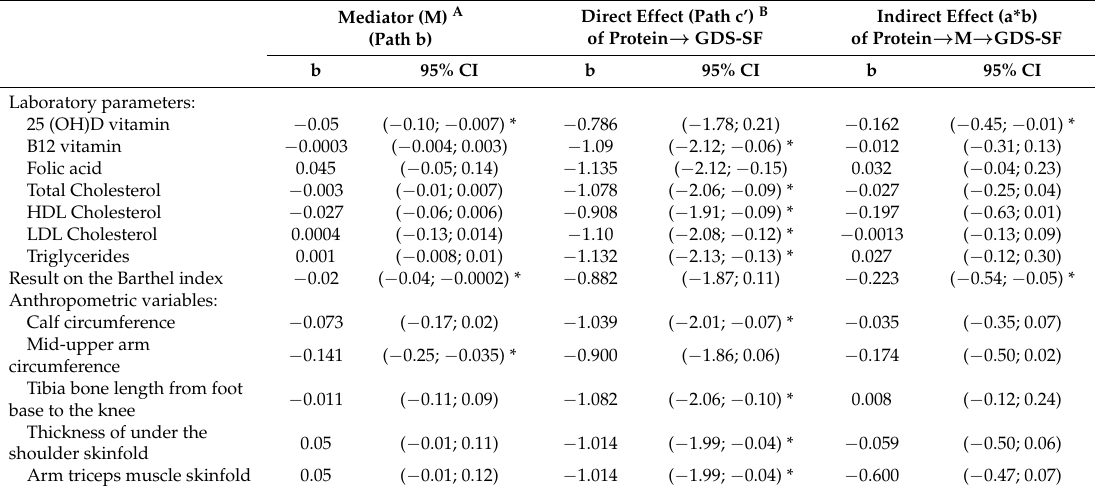
Table 4. Mediation effect tested for correlation between depression and protein